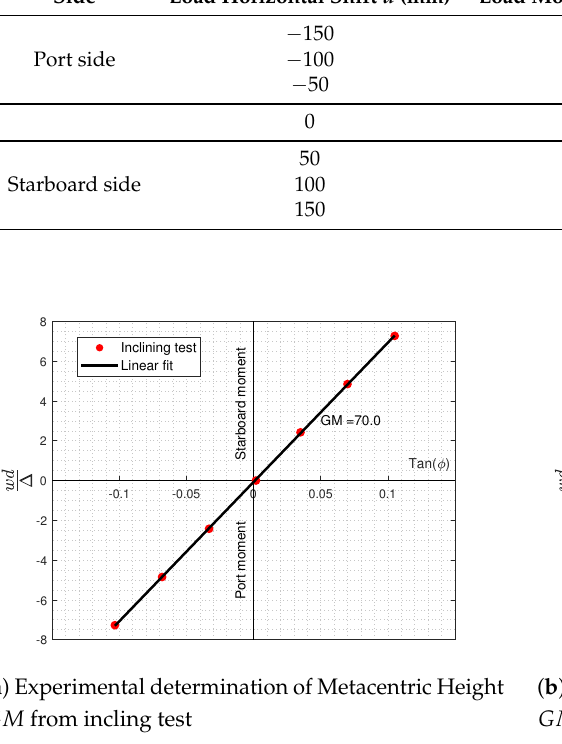
Figure 10. Determination of Metacentric Height GM from experimental inclining test data and numerical modelling using ORCA3D